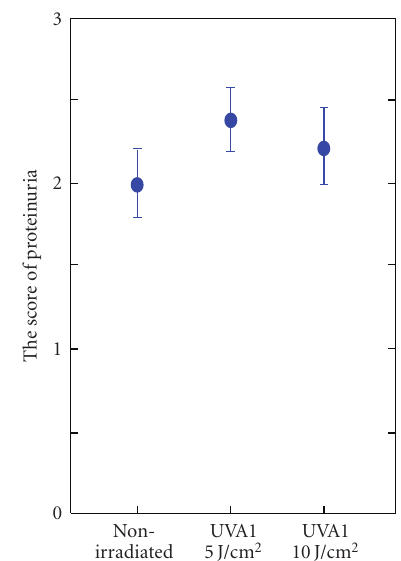
Figure 2: Degree of proteinuria in MRL/lpr mice of the three groups. There were no significant di ff erences among the three groups. UVA1 irradiation had no e ff ect on the degree of proteinuria. The data represent means ± 1